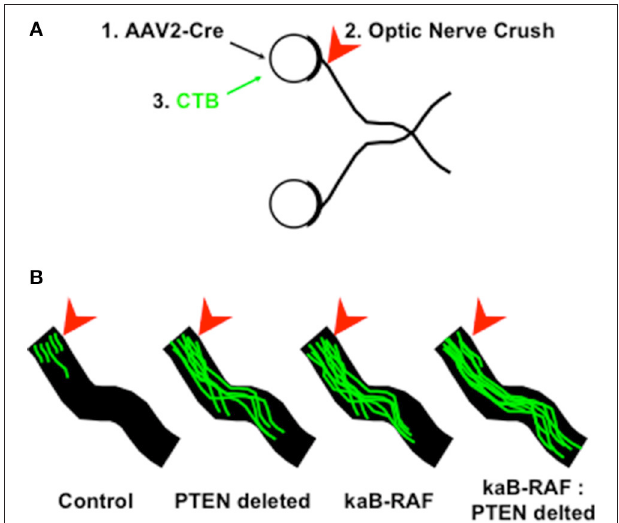
FIGURE 2 | MAP kinase pathway activation and de-repression of the PI3K/Akt pathway synergizes optic nerve regeneration. (A) Optic nerve crush experiments proceeded as follows: (1) Cre-expressing Adeno-associated virus-2 (AAV2) was injected into the eye 2 weeks prior to injury to allow for Cre expression to build up in retinal ganglion cells which are preferentially transduced by AAV2; (2) Optic nerves are crushed (arrowhead) in control and AAV2-Cre transduced animals and (3) Cholera Toxin B (CTB) conjugated to Alexa Fluor 488 is injected into the eye and tissue was processed for optic nerve imaging. (B) Representative images of regenerating optic nerves (green) from indicated genotypes: Control, PTEN deleted, kinase-active B-RAF (kaB-RAF), and the combination of both PTEN deletion and kaB-RAF. The figure is based on data presented previously ( O’Donovan et al., 2014 ).